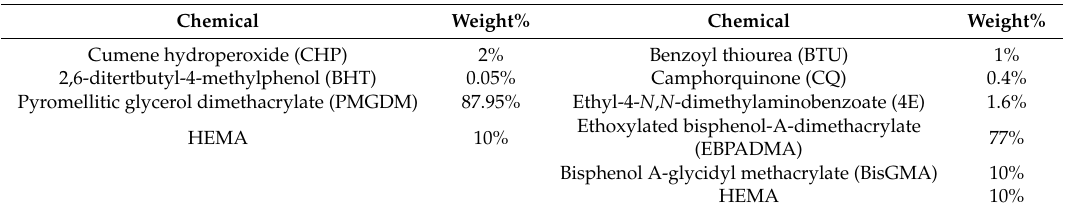
Table 2. Chemical composition of PEHB monomers with 0% dimethylaminohexadecyl methacrylate (DMAHDM).